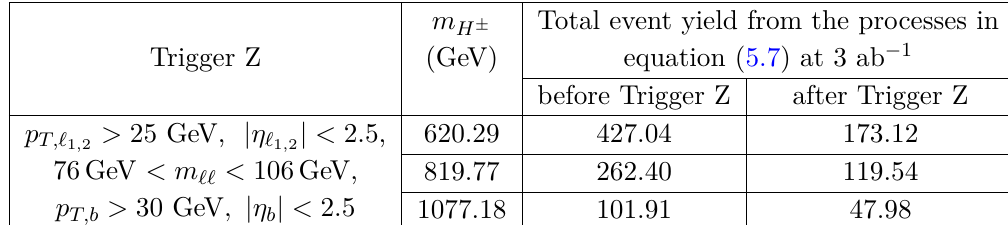
Table 30. The event yield at 3 ab − 1 from all the processes before and after, applying trigger cuts and p > 100 GeV, | η | < 2 . 5 . T, e χ ± 1 e χ ± 1 m H ± βcγτ of Fraction of events after Trigger Z in % within